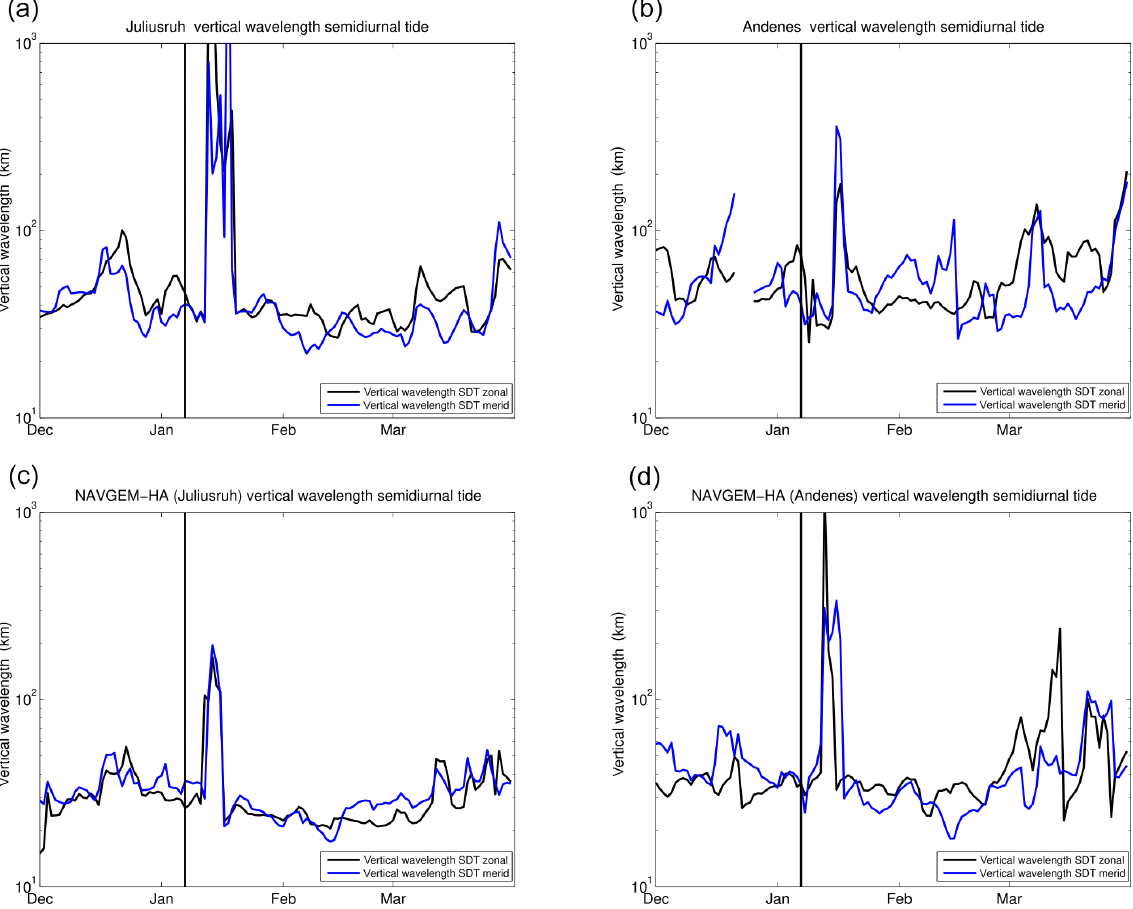
Figure C1. Time series of the vertical wavelength of the semidiurnal tide at Juliusruh and Andenes. The two upper panels (a, b) denote the meteor radar observations for both locations. The lower panels (c, d) are obtained from NAVGEM-HA.